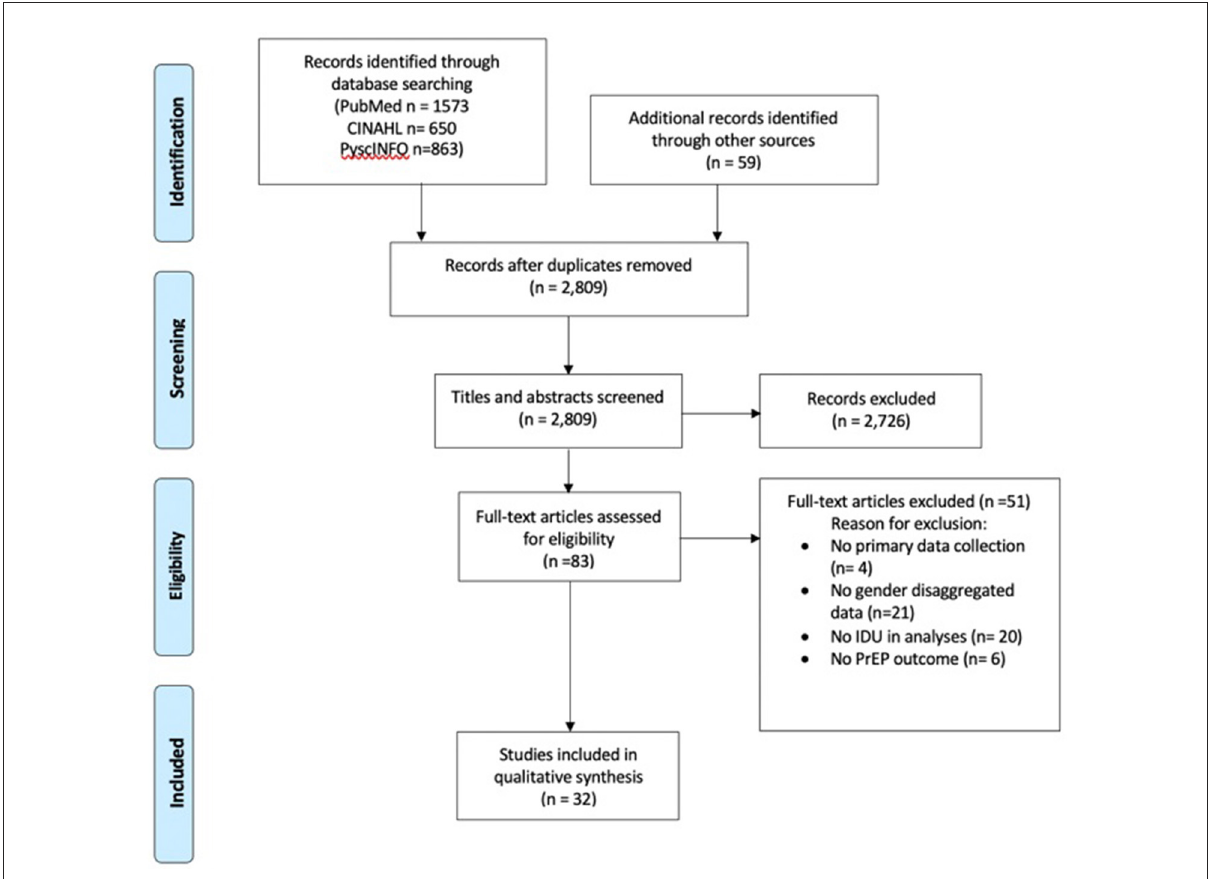
FIGURE2 PRISMA flow